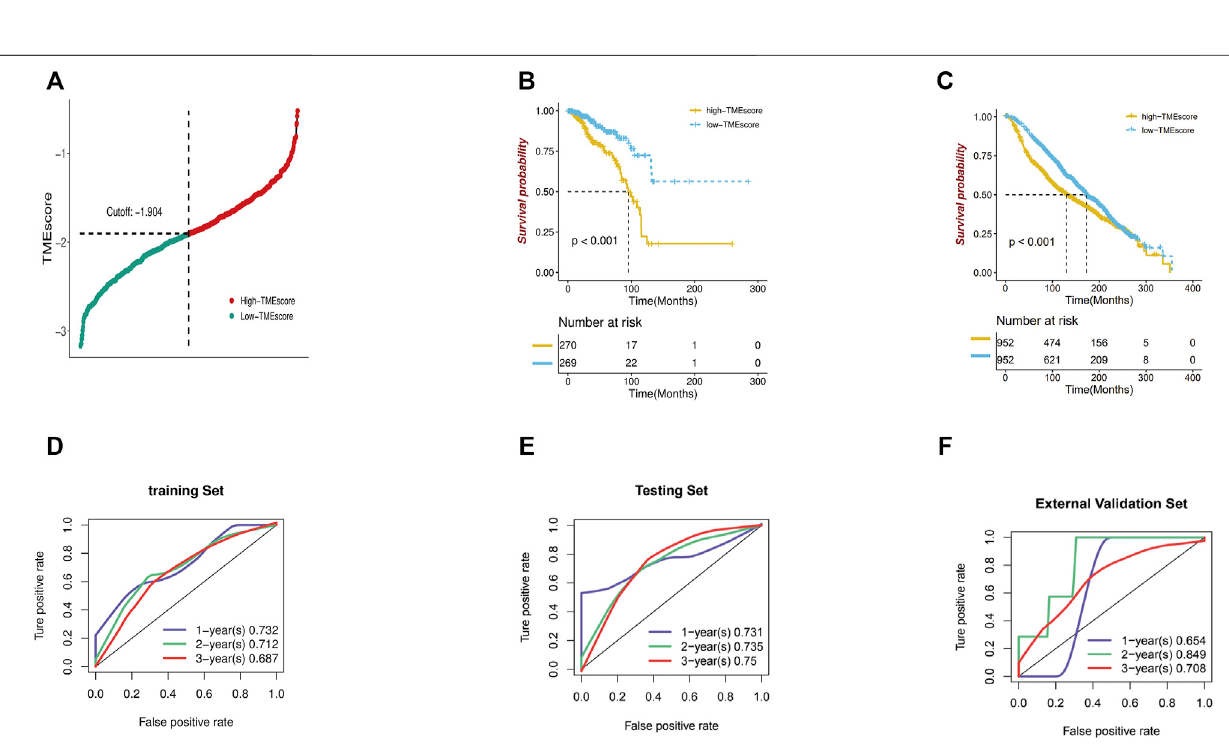
Frontiers in Molecular Biosciences |